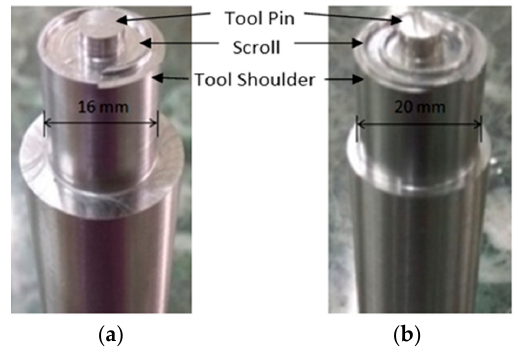
Figure 3. FSP tools having diameter ( a ) 16 mm, and ( b ) 20 mm.